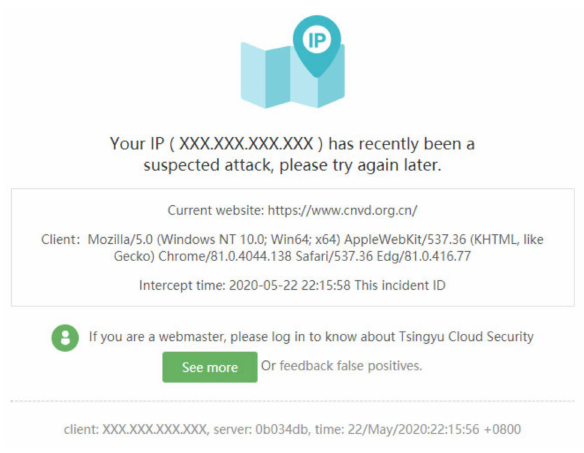
Figure 2. Example of CNVD access restriction message, anonymised screenshot of [27] accessed during the restriction period.